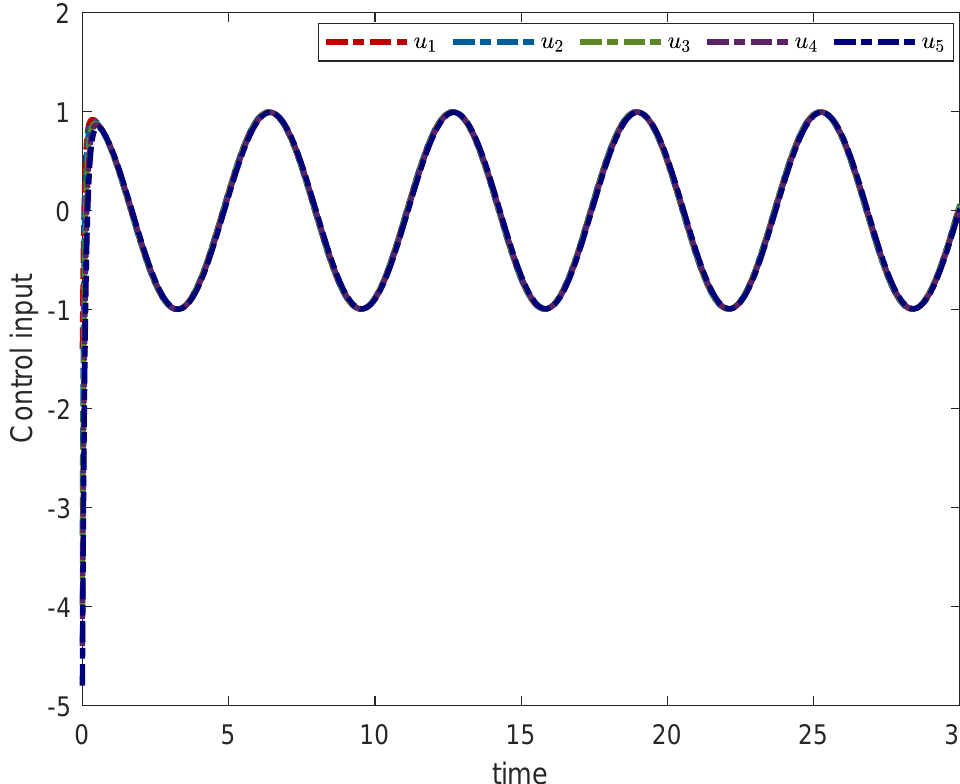
Figure 15. The trajectories of control input u i based on the algorithm proposed in this paper.